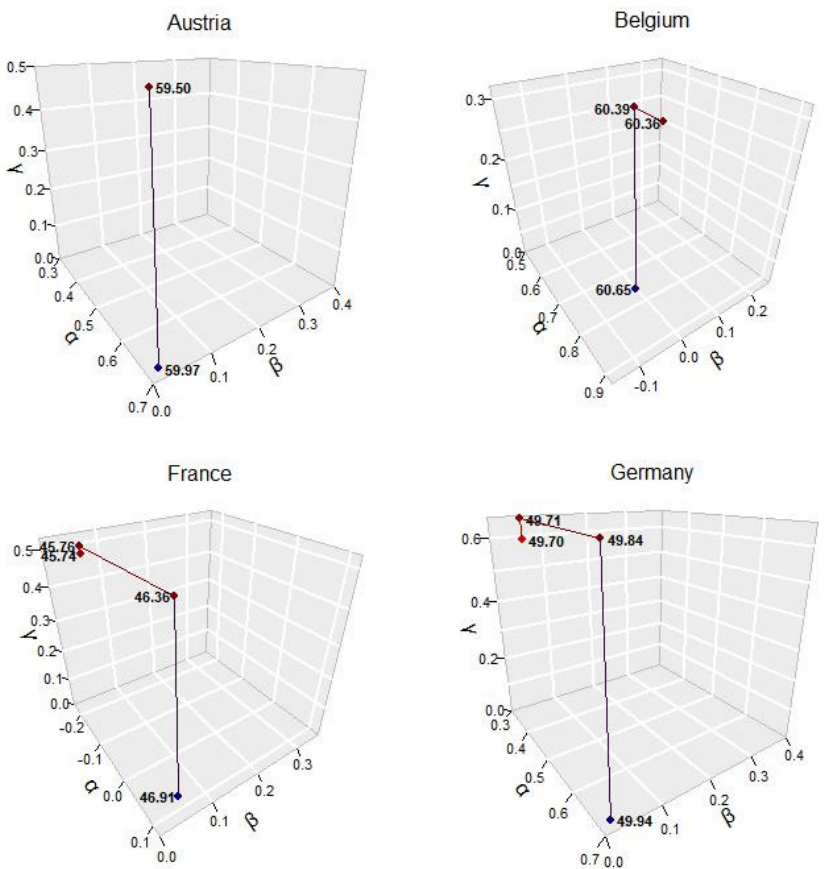
Figure 6. Extended 2D- LQ optimums for EA-19 countries (2015). Source: internal based on Eurostat data [naio_10_cp1700].